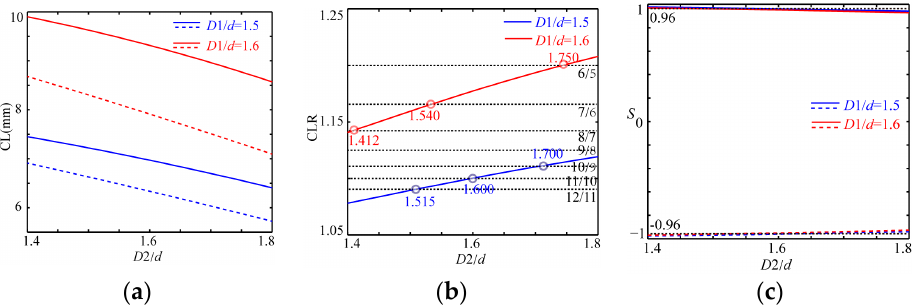
Figure 7. The variation relations of CLs ( a ), CLRs ( b ) and S s ( c ) with D 2/ d for fixed D 1/ d . In the case of D 1/ d = 1.5, the values of CLRs close to 12/11, 11/10 and 10/9 emerge at D 2/ d = 1.515, D 2/ d = 1.600 and D 2/ d = 1.700, respectively; the lengths of the CLs are, respectively, 7.185 mm/6.585 mm, 6.970 mm/6.335 mm and 6.699 mm/6.034 mm, where the S s are, respectively, 0.9679/ − 0.9669, 0.9605/ − 0.9594 and 0.9511/ − 0.9498; and thus, the